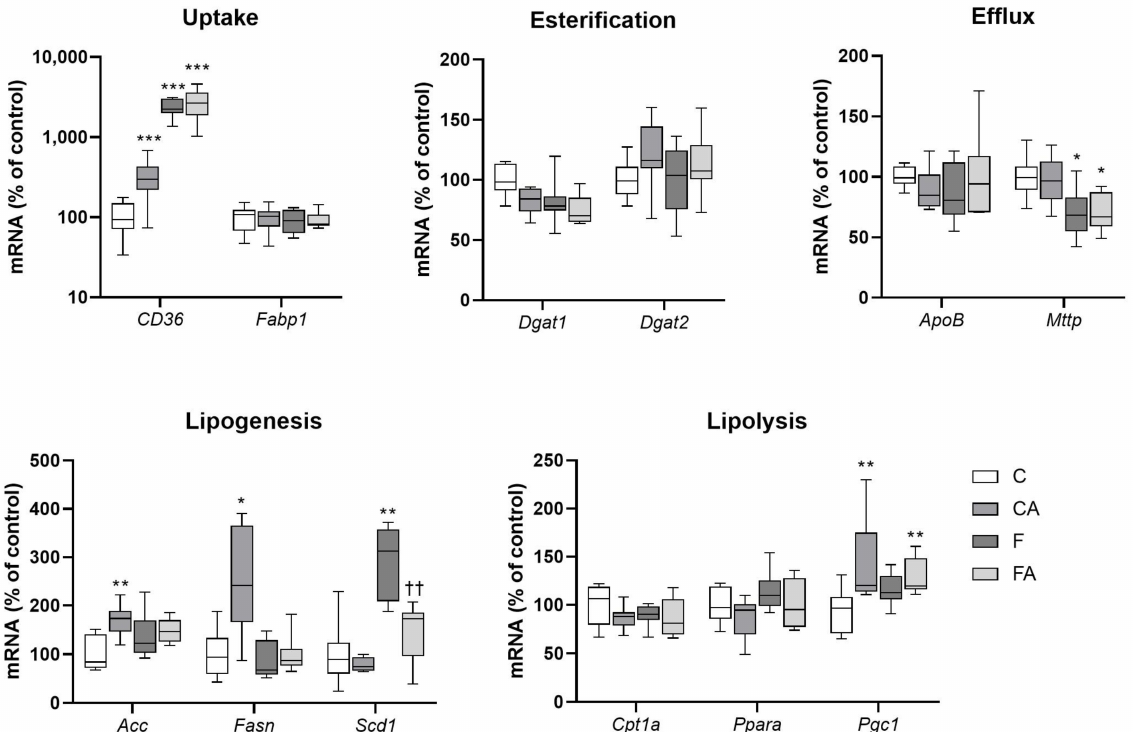
Figure 3. Atorvastatin and NASH modulated the expression levels of lipid metabolism genes in the liver. NASH was induced in mice by 24 weeks of F diet consumption, with atorvastatin (A) administered orally (20 mg/kg/day) during the last three weeks. Corresponding control groups received a chow (C) diet. Data are presented as median values, with boxes and whiskers representing the interquartile range and fifth to 95th percentiles, respectively. * p < 0.01, ** p < 0.01, and *** p < 0.001 atorvastatin and/or F-diet vs. vehicle-administered chow diet–treated mice; †† p < 0.01 atorvastatin-treated vs. vehicle-treated NASH